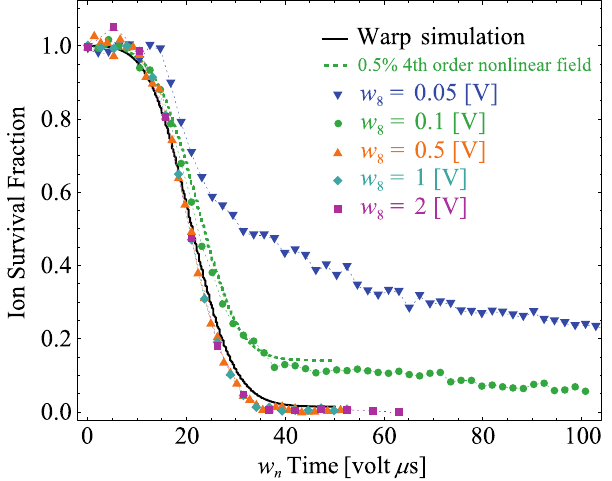
FIG. 5. Time evolution of ion losses when the LPT operating point is fixed exactly on the integer resonance at ν 0 ¼ 8 in Fig. 4(c). Five different sinusoidal amplitudes are considered to change the resonance strength. The solid curve represents the corresponding W ARP simulation result in which perfectly aligned quadrupole rods have been assumed, and the dashed curve where nonlinearities have been introduced. The initial plasma temper- ature is set at 0.5 eV.